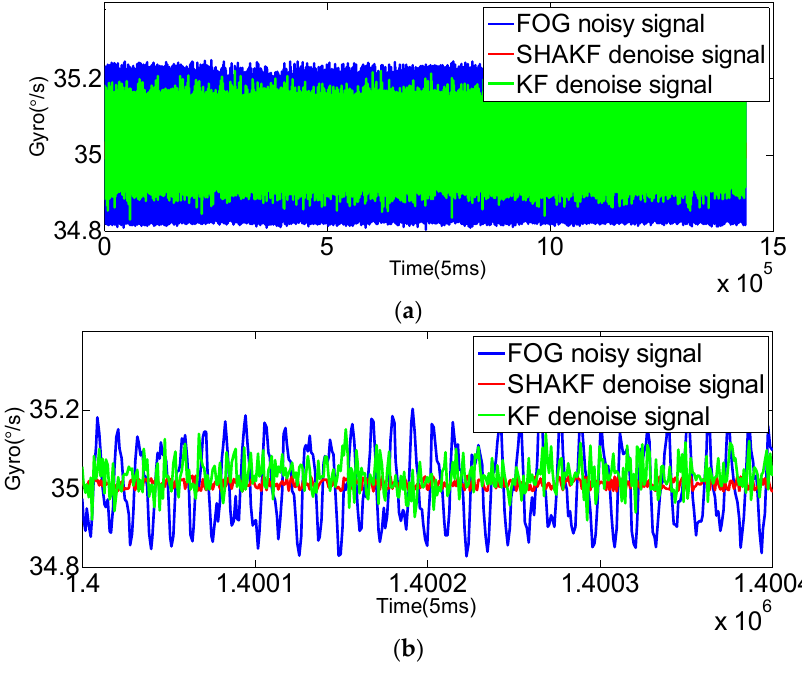
Figure 12. Comparison of the results before and after denoising for the FOG dynamic signal at a rate of 25°/s. ( a ) Denoising results of the FOG dynamic signal ( x -axis) for 2 h; ( b ) local enlarged graphs. Sensors 2016 , 16 , 1073